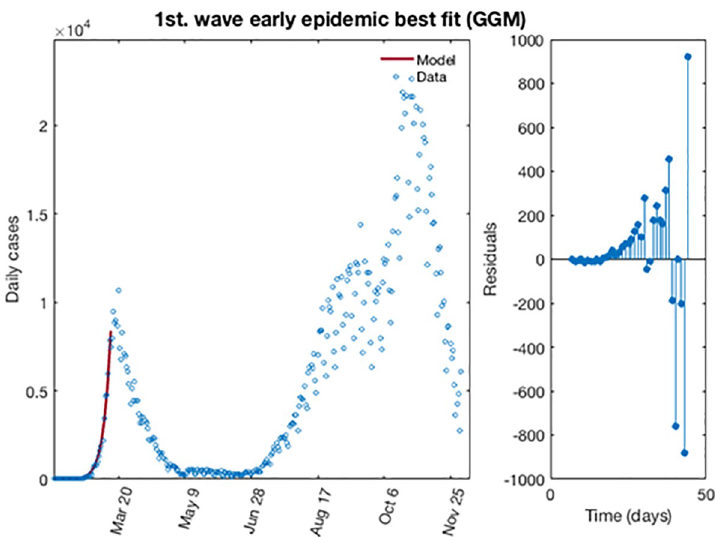
residuals are displayed in the right panel.